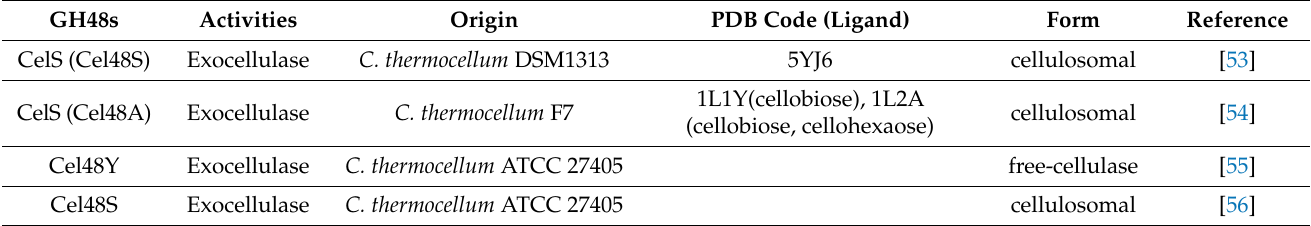
Table 1. Characterized and structure-determined GH48